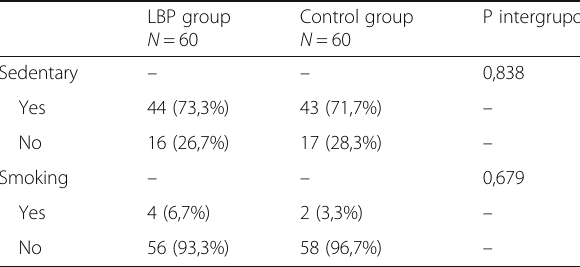
Table 2 Ratio of sedentary and smoking among nurses